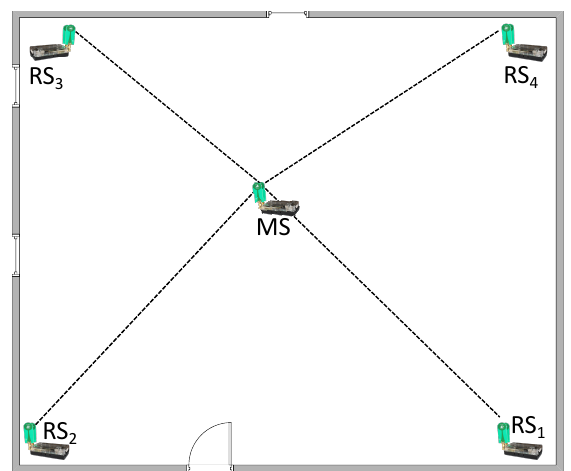
Figure 5. UWB-based Indoor Localization System (ILS) principle. MS , Mobile Station; RS i , Reference Station i